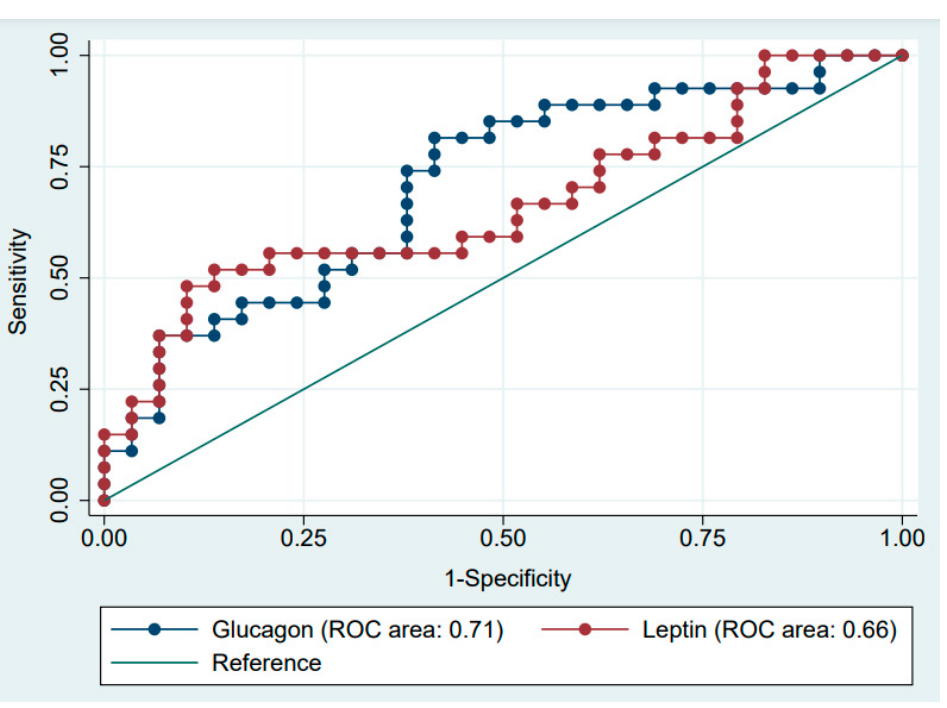
Figure 1. The receiver operating characteristic (ROC) analysis for prediction of overweight/obesity based on the serum levels of glucagon and leptin in childhood acute lymphoblastic leukemia survivors.